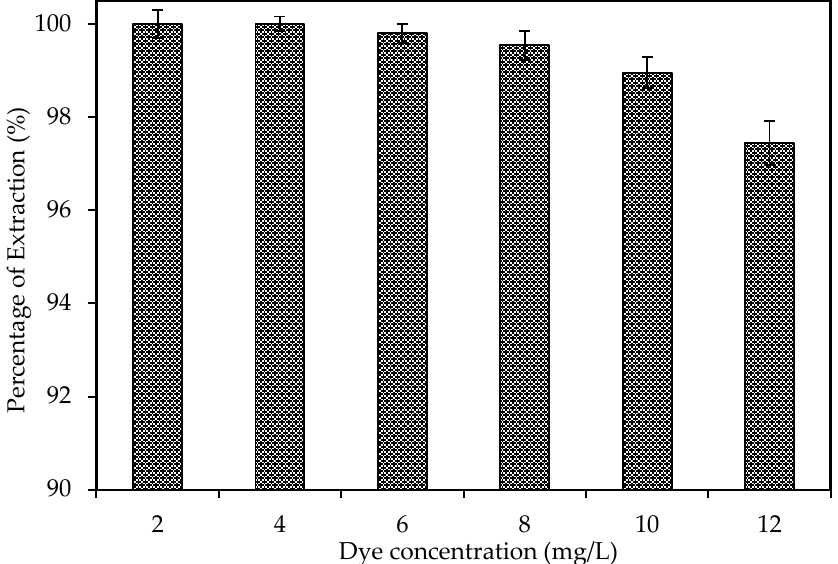
Figure 6. Dye extraction of M6 membrane at different dye concentrations. Table 4. Influence of the initial dye concentration on permeability ( P ) and flux ( J ) of the mem- brane.